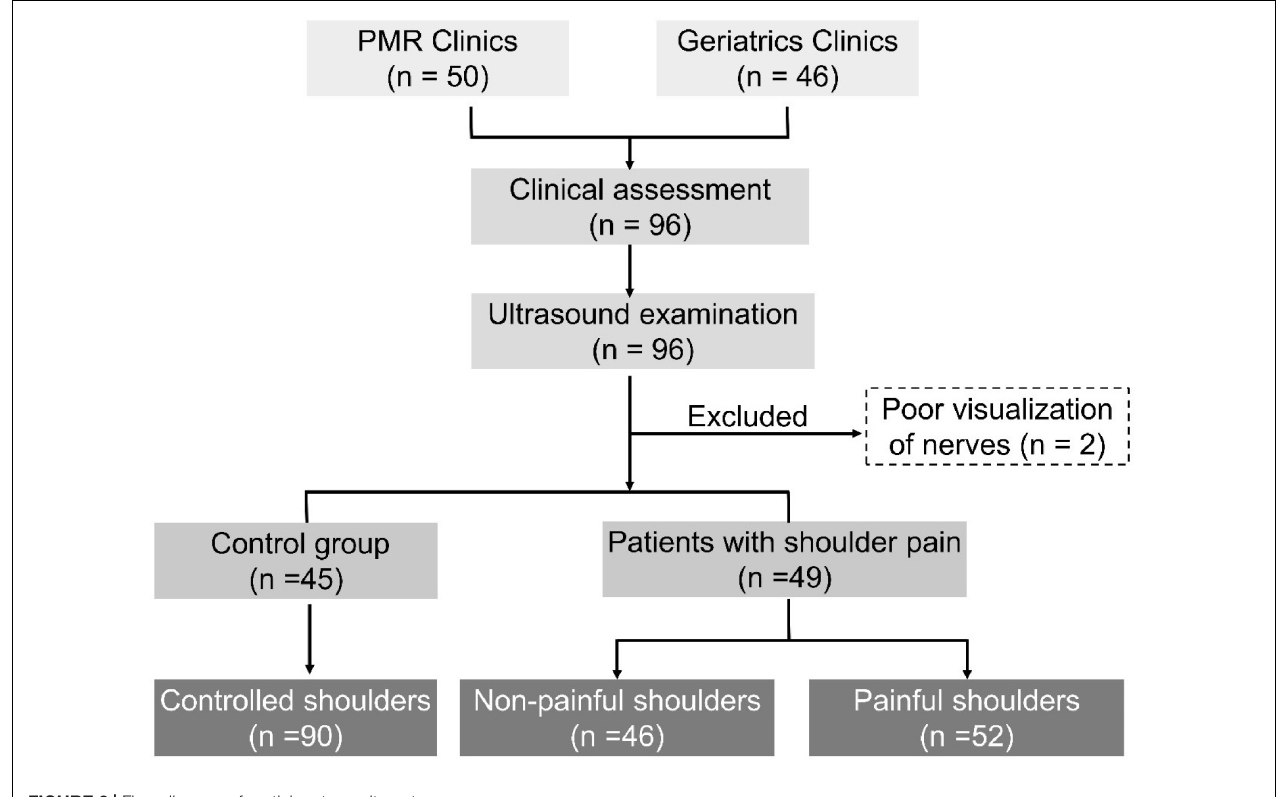
FIGURE 2 | Flow diagram of participant recruitment. TABLE 1 | Subject characteristics and suprascapular nerve (SSN) cross-sectional area measurements of the study